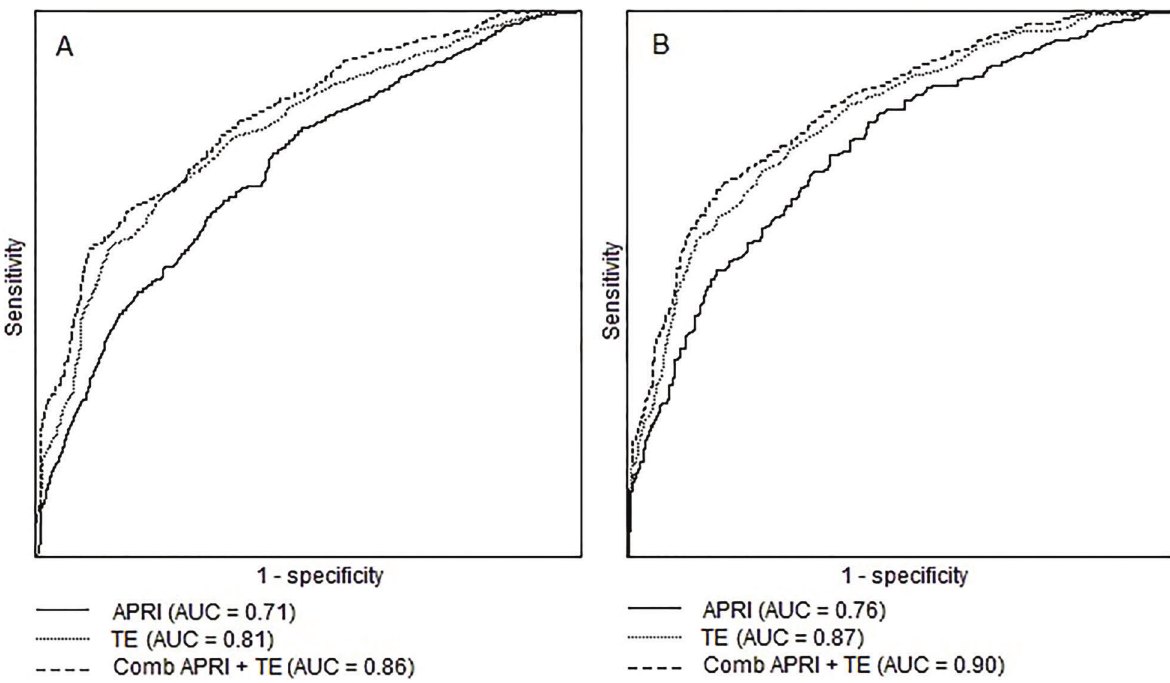
Figure 3. Receiver-operating-characteristic (ROC) curves of noninvasive tests transient elastography (TE), aspartate aminotransferase to platelet index (APRI) and a combination of both tests for signi fi cant ( A ) and advanced ( B ) fi brosis in chronic hepatitis C patients compared to histological analysis through liver